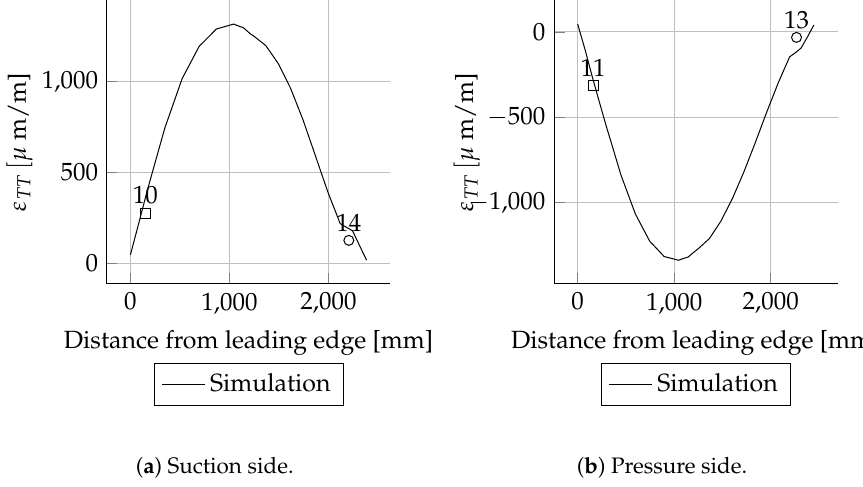
Figure A43. Strain comparison ε LL at radial position R = 2700 mm for Mymin load case.